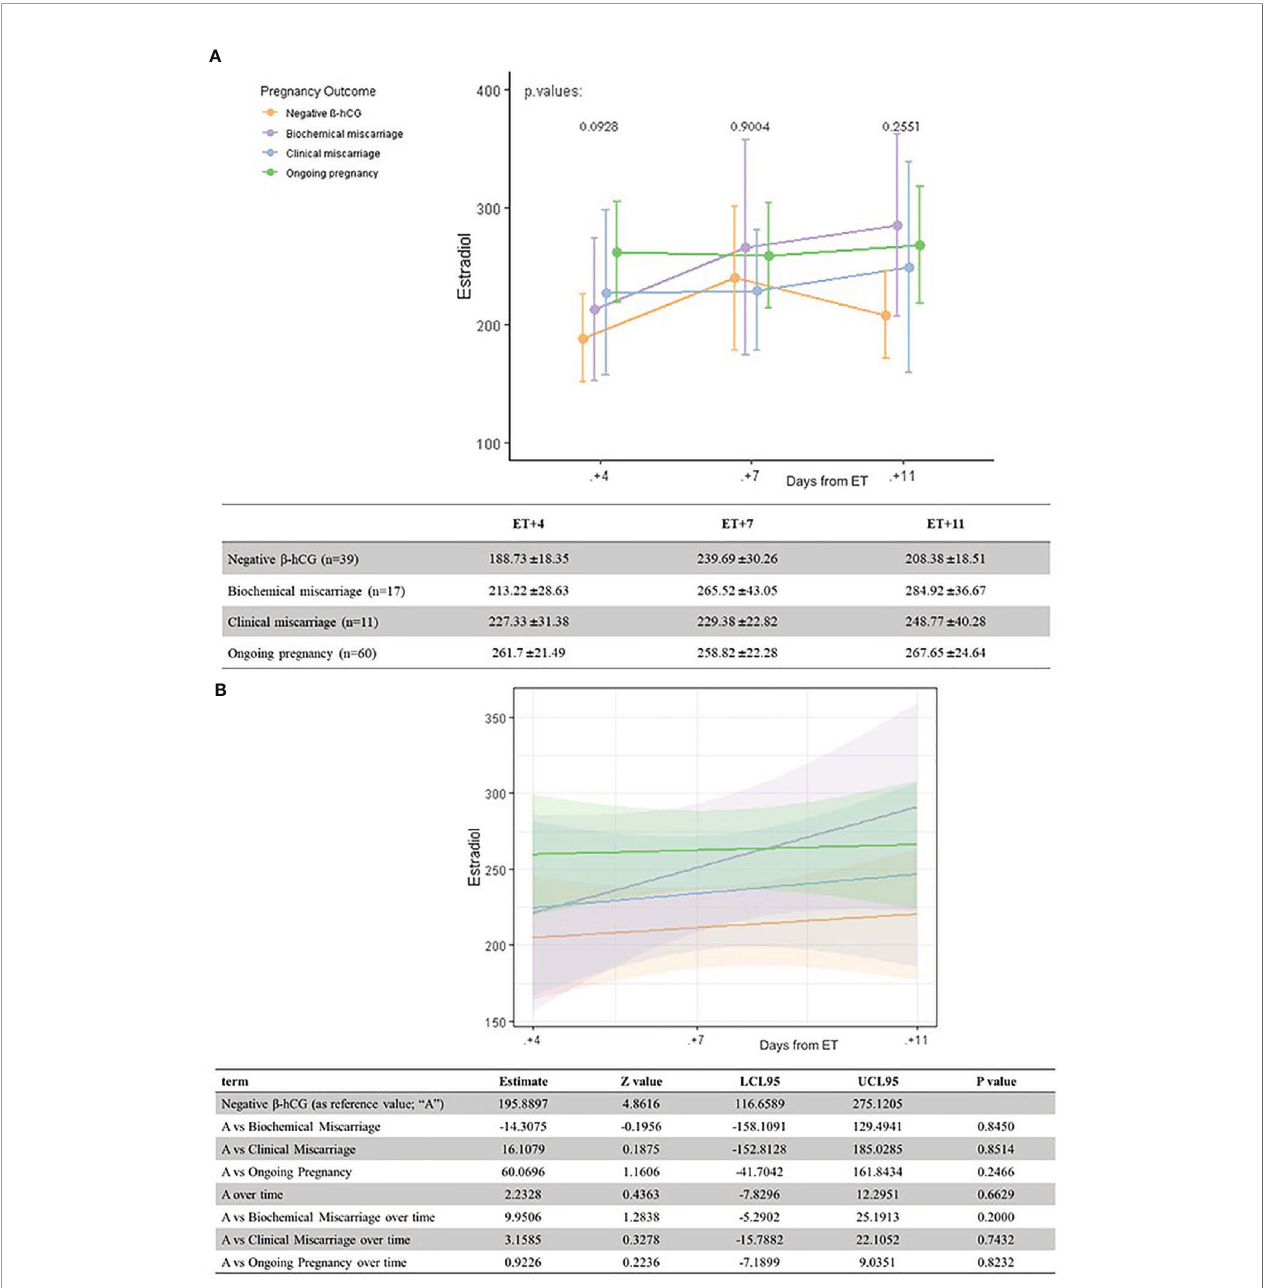
FIGURE 2 | Univariate analysis (A) and linear regression model (B) of serum estradiol levels (pg/ml) according to pregnancy outcome and the day after